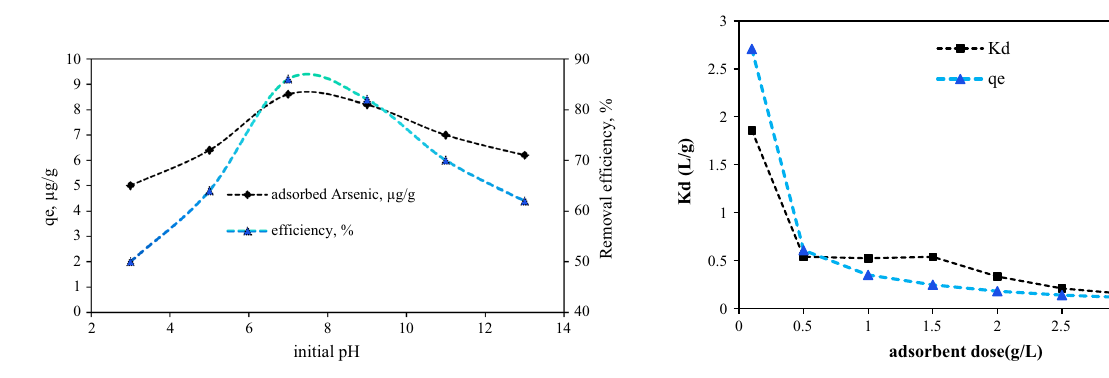
Fig. 1 Effect of initial pH of solution on arsenic removal using modi- fied saxaul ash (initial arsenic concentration of 100 µg/L, adsorbent dosage of 1 g/L, contact time of 60 min and temperature of 298 K)